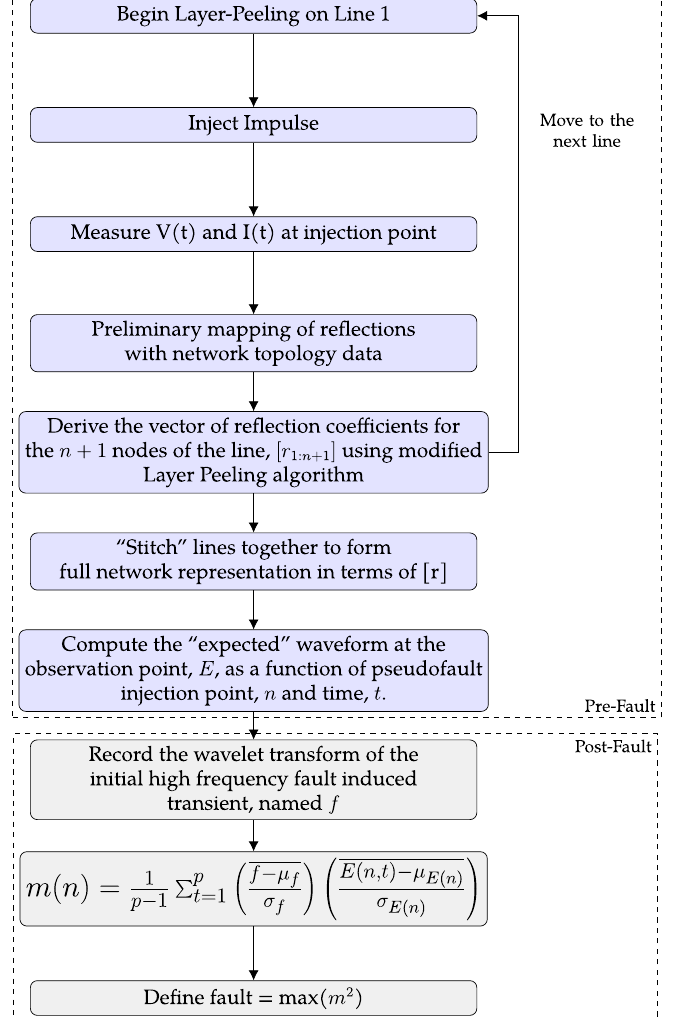
Figure 3. Overview of the Proposed Algorithm.